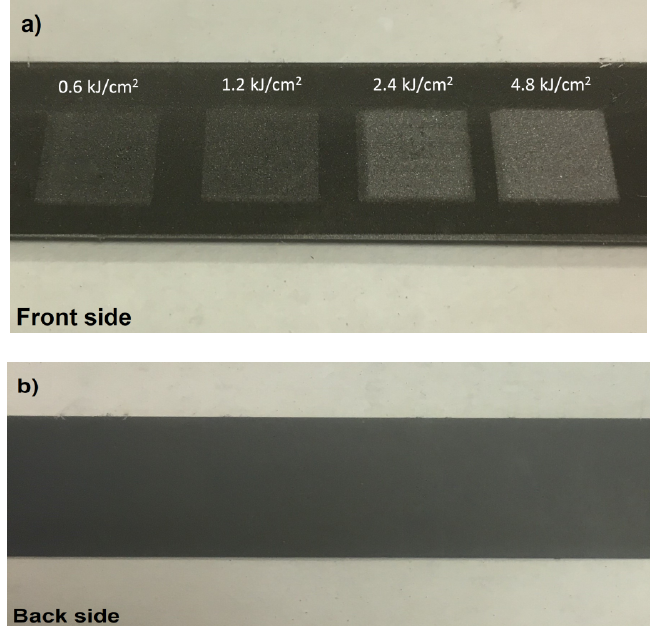
Figure 3. ( a ) Picture of the front surface of a carbon strip showing four square areas treated at different values of total accumulated laser fluence (increasing from left to right). ( b ) Picture of the same portion of the carbon strip shown in ( a ) taken from the back surface of the Plexiglas ® plate.